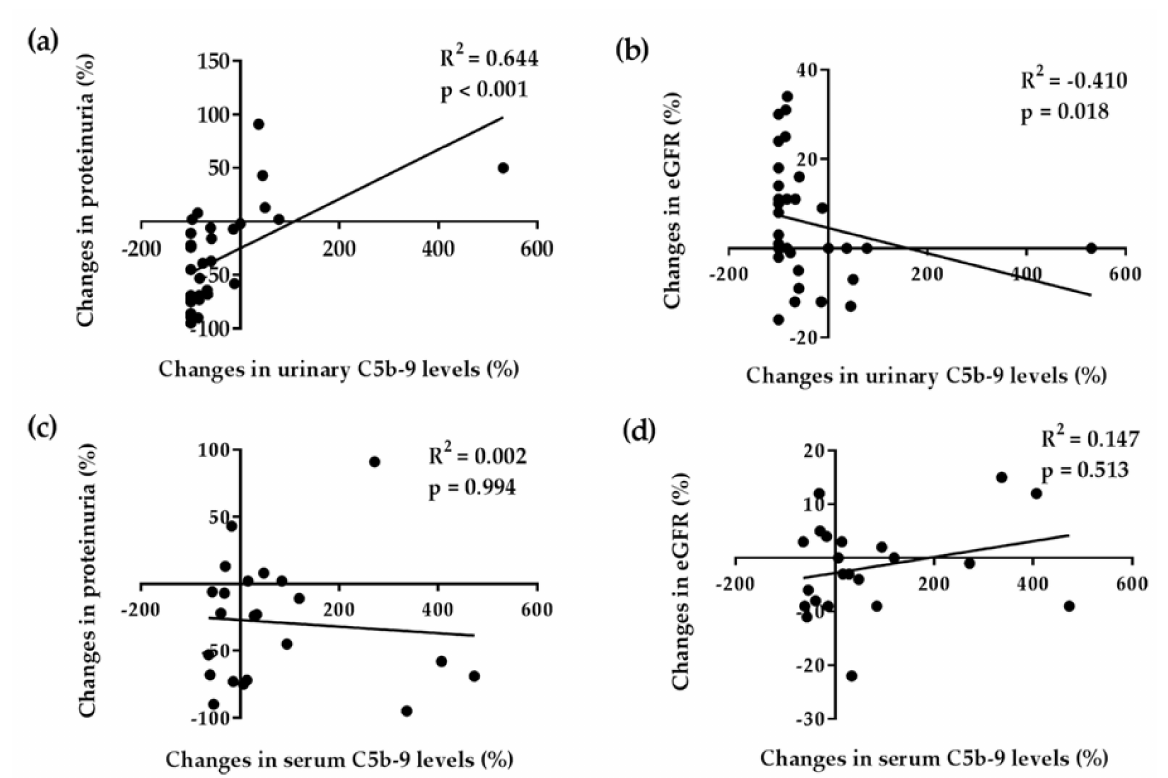
Figure 1. Relationships between changes in serum and urinary complement C5b-9 levels, proteinuria, and estimated glomerular filtration rate (eGFR) after medical treatment. Changes in urinary levels of C5b-9 positive correlate with changes in proteinuria ( a ) and inversely correlate with changes in eGFR ( b ) at 6 months after medical treatment. Changes in serum levels of complement C5b-9 does not correlate with changes in proteinuria ( c ) and eGFR ( d ). Data were analyzed by Spearman’s rank correlation